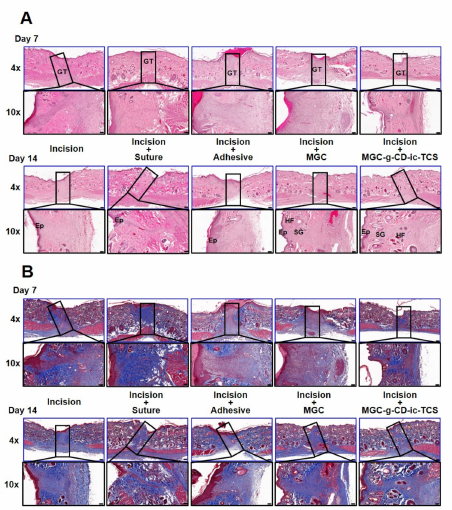
Figure 8. ( A ) H&E-stained and ( B ) MT-stained images of untreated incision, and incisions treated with suture (incision + suture), cyanoacrylate (incision + adhesive), MGC (incision + MGC) and MGC-g-CD-ic-TCS (incision + MGC-g-CD-ic-TCS) after 7 and 14 days. The slides were observed at 4 × (200 µ m) and 10 × (100 µ m), respectively. At 4 × images, the rectangle boxes indicate incised part. GT-granulation tissue; EP-epithelial layer; HF-hair follicles; SC-sebaceous